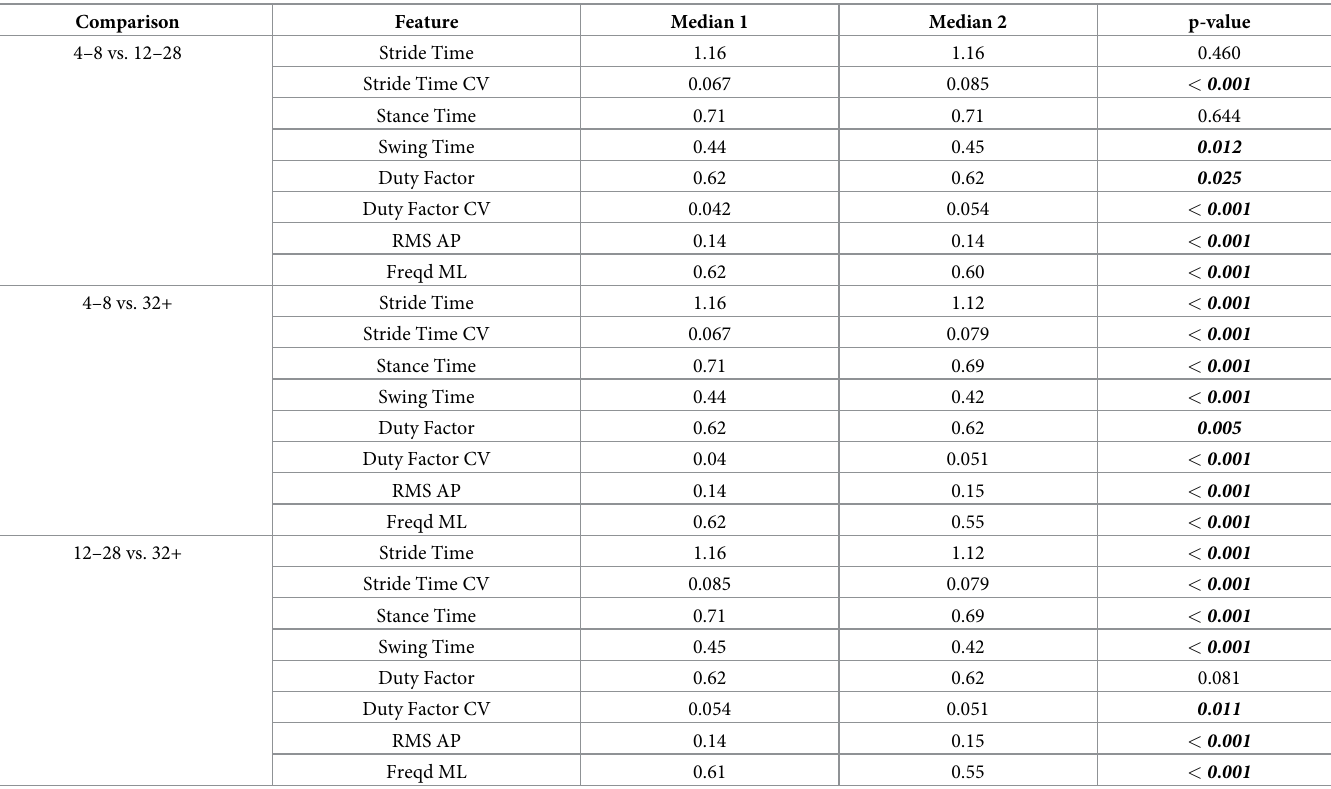
Table 3. Difference of Medians Testing for free-living Gait parameters from differing bout lengths. Comparison